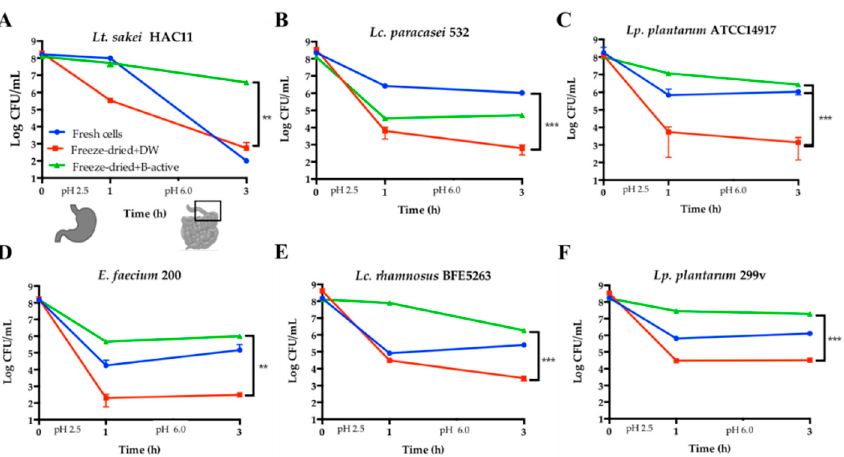
Figure 4. B-active impact on the survivability of different freeze-dried putative probiotic strains, compared to fresh cultures and cells rehydrated with distilled water. ( A ) Latilactobacillus ( Lt. ) sakei HAC11; ( B ) Lc. paracasei 532; ( C ) Lp. plantarum ATCC14917; ( D ) E. faecium 200; ( E ) Lc. rhamnosus BFE5263; and ( F ) Lp. plantarum 299v, viability of fresh overnight cells (blue line), freeze-dried cells rehydrated only with distilled water (red line), and freeze-dried cells rehydrated with B-active (green line) after simulated gastro-intestinal passage (SSDP). Data are expressed as the mean ± SD, n = 3. ** p < 0.01 and *** p < 0.005; one-way ANOVA, Dunnett’s multiple comparison test.